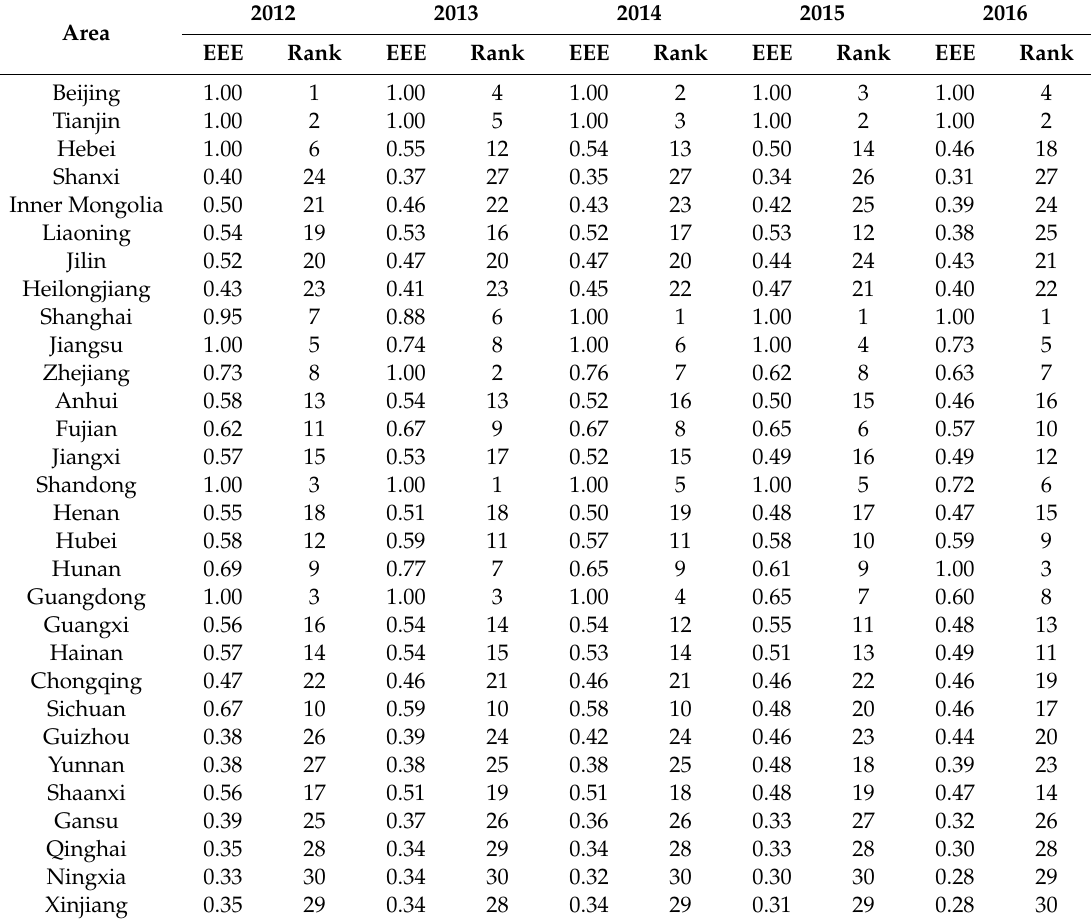
Table 2. Original EEE of 30 Chinese province-level areas from 2012 to